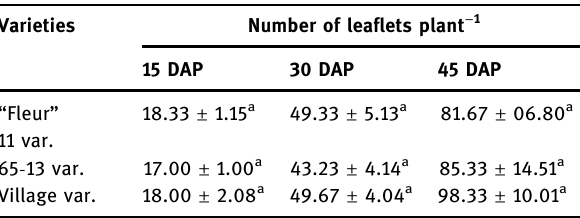
Table 4: Number of lea fl ets before phyto - extract applications Varieties